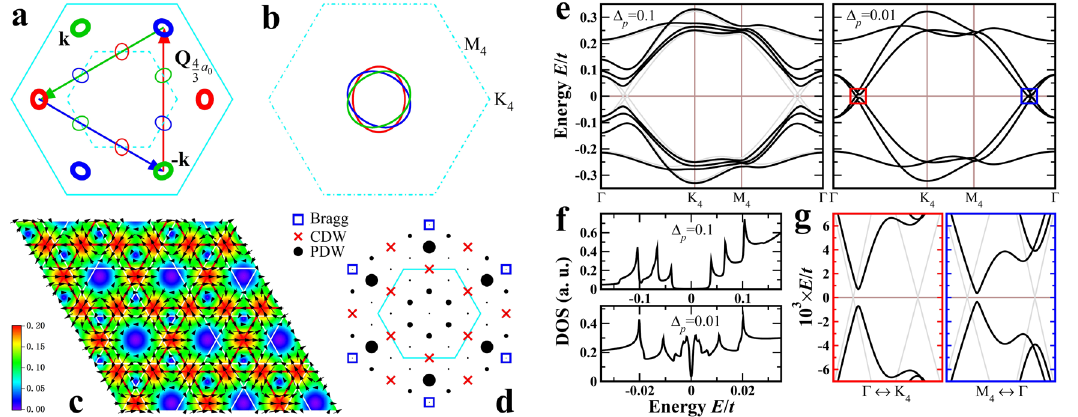
a 0 × 4 a 0 PDW 1 . e Low- 3 3